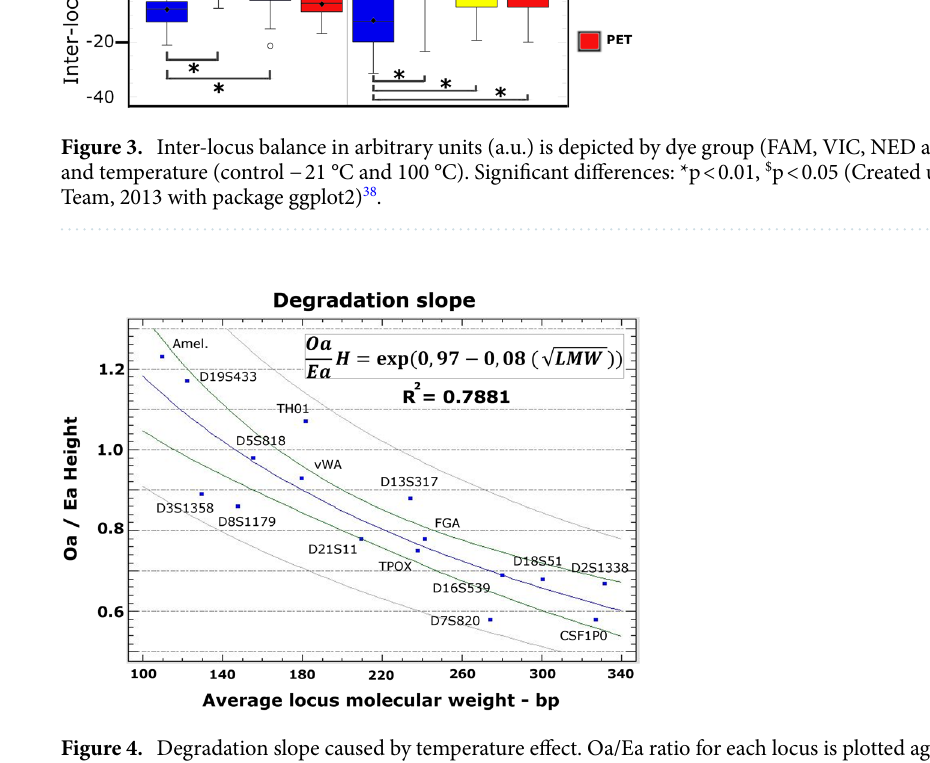
Figure 4. Degradation slope caused by temperature effect. Oa/Ea ratio for each locus is plotted against the molecular weight in base pairs for the control and 100 °C groups. Simple regression model of “Y-Logarithmic X-Square root” is represented by blue curve. Green and grey lines represent the confidence (95%) and prediction limits of the model, respectively. The equation derived from this model is shown ( Oa/Ea H Oa/Ea height ratio, LMW locus molecular weight in base